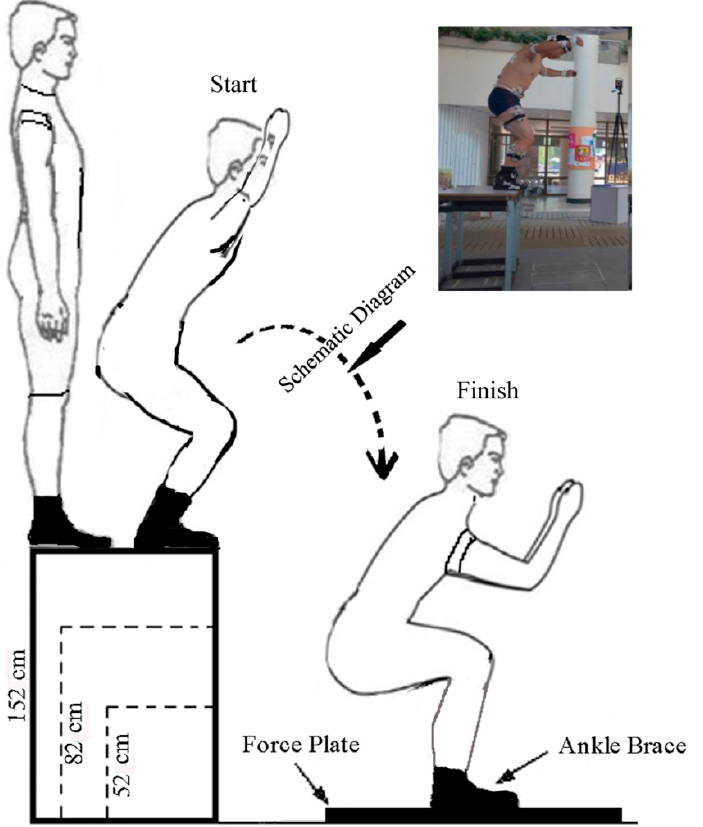
Figure 1. Landing on force plate from the different height of platform (subjects with ankle braces, boots, and no braces).